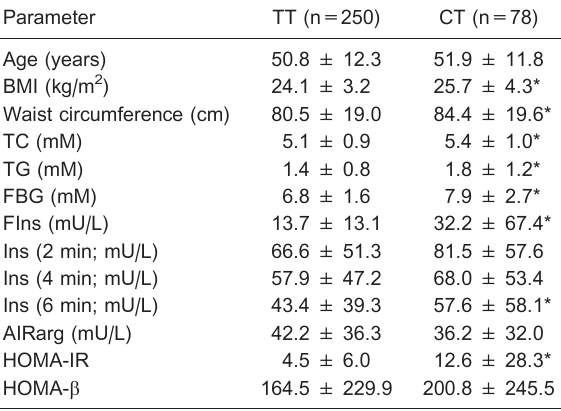
Table 4. Clinical characteristics according to genotypes of the rs12504538 polymorphism of the ELOVL6 gene.